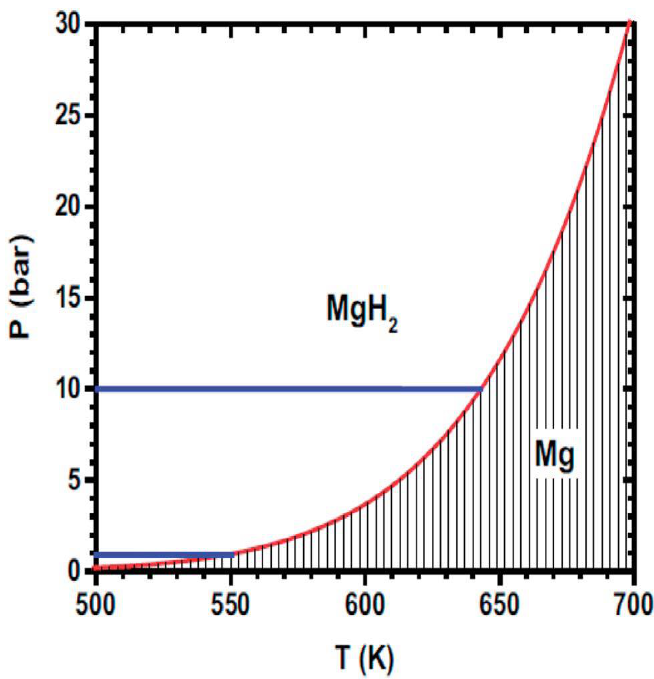
Figure 9. The variation of plateau pressure as a function of temperature for magnesium hydride [24].